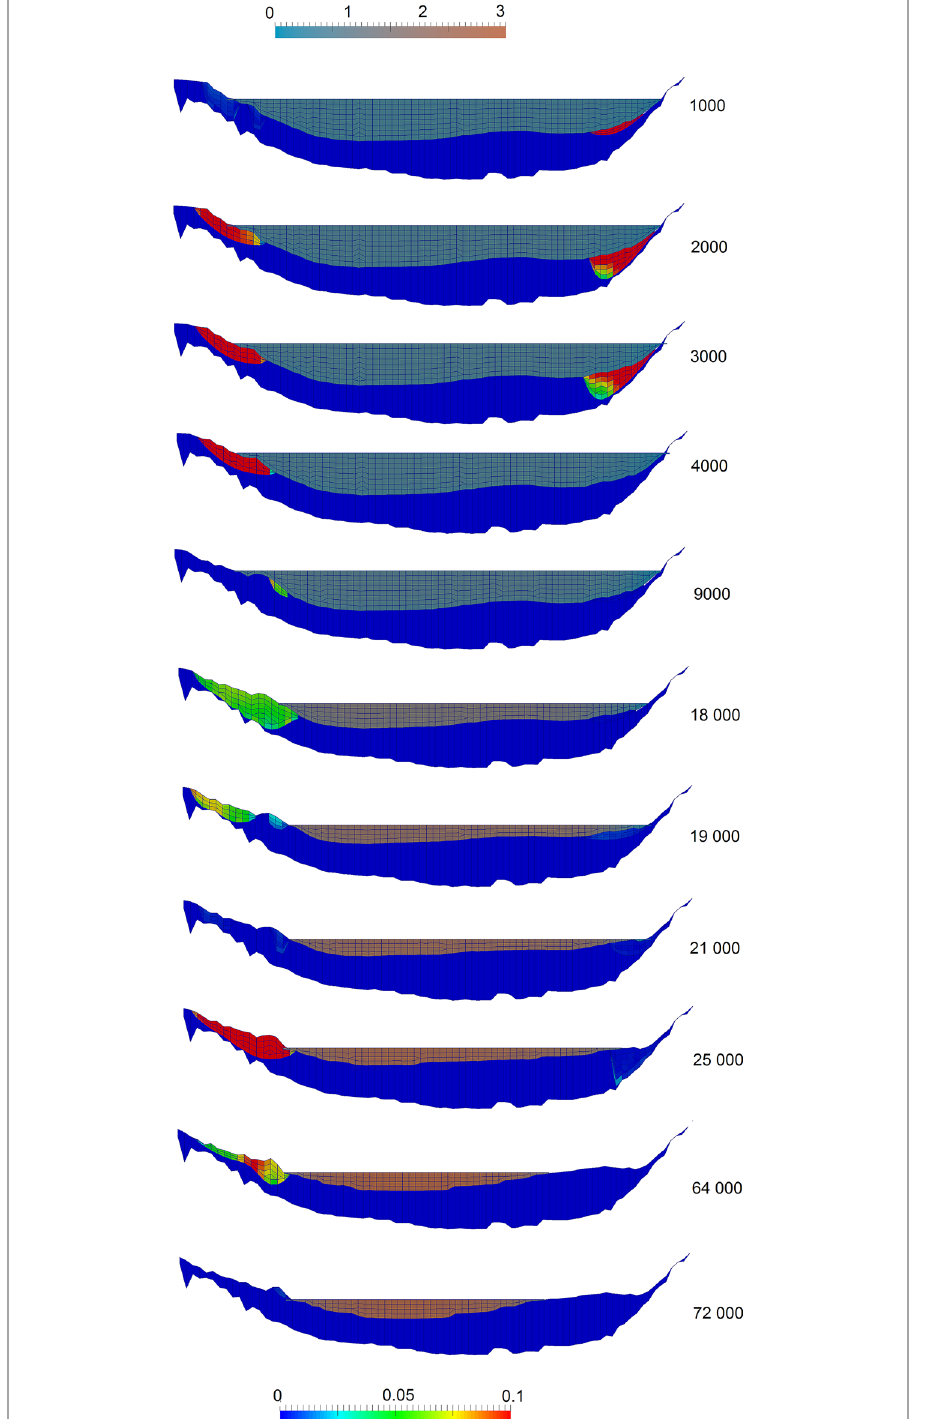
Fig. 16 Cross section 373.6 Fig. 10 showing the soil and water grid at different times (in seconds) after the start of the flushing. The upper legend is the water velocity in m/s. The lower legend is the soil velocity in